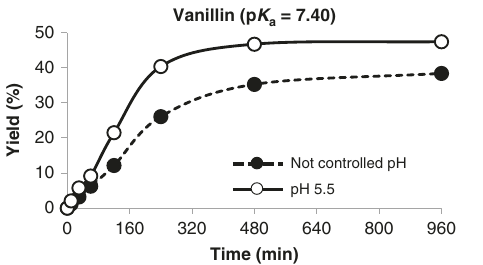
Fig. 6 Production of vanillin arabinopyranoside with and without pH control. The initial donor/acceptor balance was 2/1 (mole/mole) and the acceptor conversion (%) over time was determined by HPLC at different time intervals for 16 h. Yield pro fi les are represented by a dashed line and black circles for non-controlled pH and by a continuous line and white circles for controlled pH. Mean values are shown together with the corresponding standard error ( n = 3 independent experiments). Source data are provided as a Source Data fi